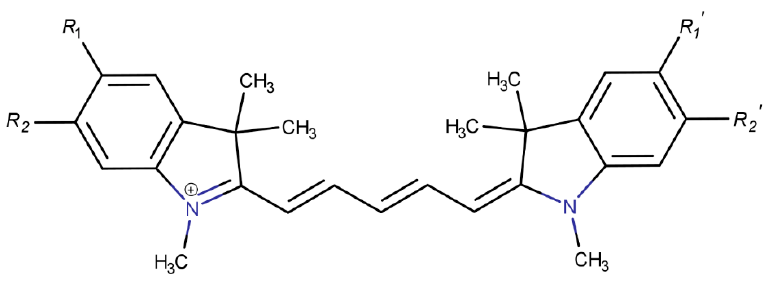
Figure 1. Molecular structure of a Cy5 (1,1'-dimethyl-3,3,3',3'-tetramethylindocarbocyanine) dye. Hydrogens at ‘R’ locations were replaced with substituents. Table 1. Substituents, their corresponding Hammett constants ( σ p ), and the classifications used in the current study. Negative values correspond to electron donating substituents and positive values correspond to electron withdrawing substituents.